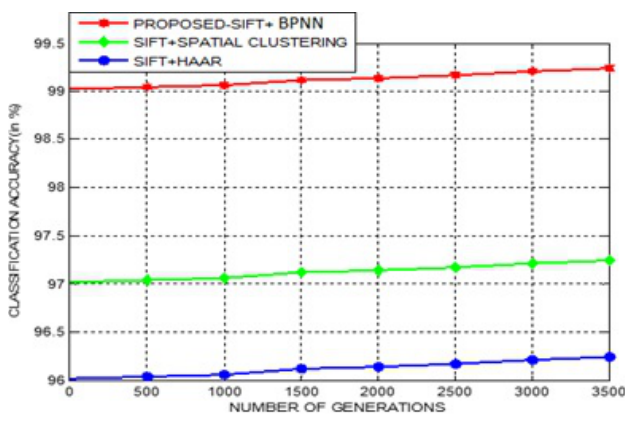
to the SIFT+SPATIAL CLUSTERING and SIFT+HAAR methods used for analysis. In contrast, the false positive